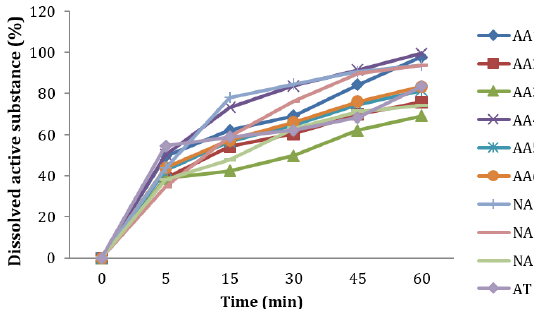
Figure 1. Dissolution profiles of atorvastatin calcium’s liquisolid tablets and a branded tablet available on the market (AT ® )